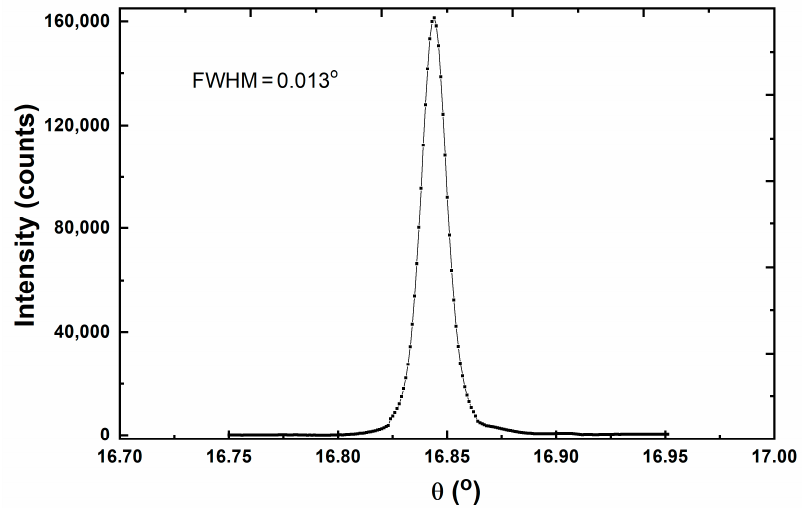
Figure 6. XRC of the LYSB crystal on the (003) diffraction plane. (Reprinted with permission from ref. [13], copyright 2019 American Chemical Society).